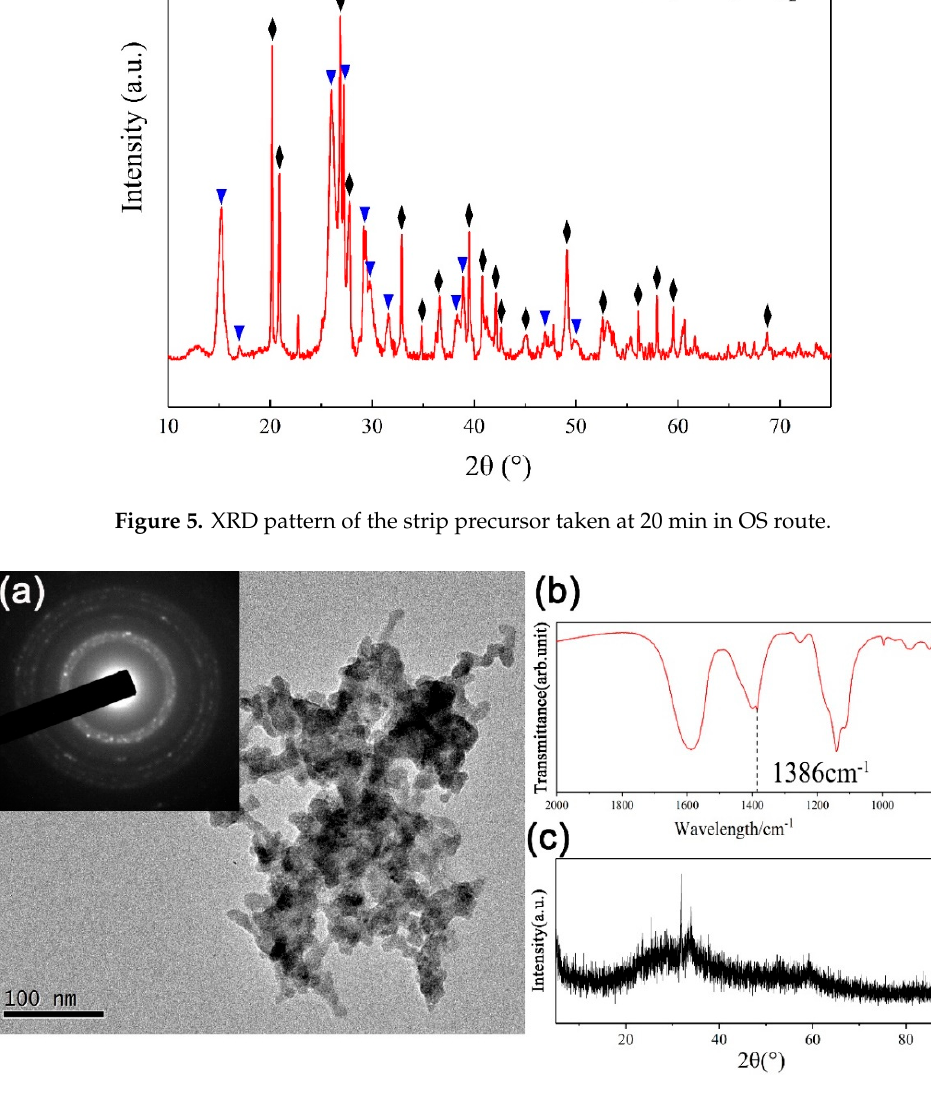
Figure 6. Phase analysis of the particle aggregates precursor at 0 min in OS route: ( a ) TEM and SAED pattern; ( b ) FT-IR spectra; and ( c ) XRD pattern.